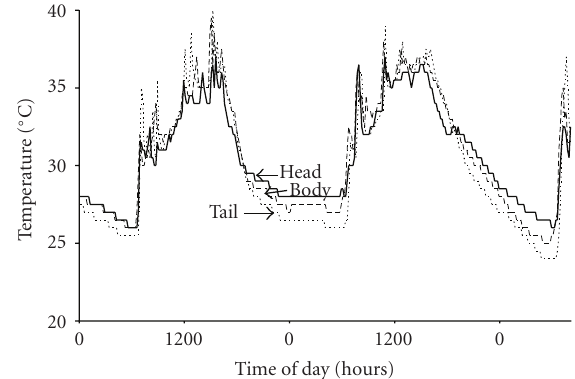
Figure 6: Profile of a representative Komodo dragon with ibutton loggers recording the skin temperature of the head, body, and tail over a two-day